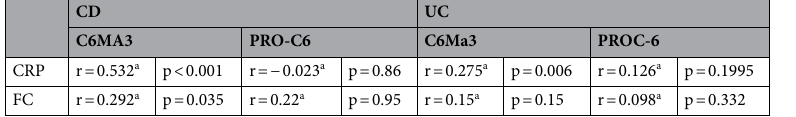
Table 3. Correlations between CRP and FC and and the biomarkers C6Ma3 and PRO-C6. a Spearman r; Statistical significance was defined as p <